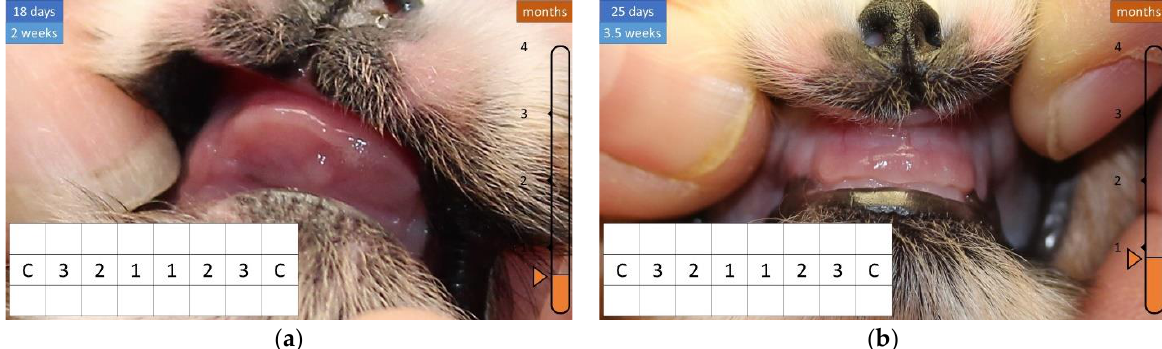
Figure 3. Development of the teeth in the first 18 and 25 days of life. ( a ) There are no teeth. ( b ) There are no teeth.